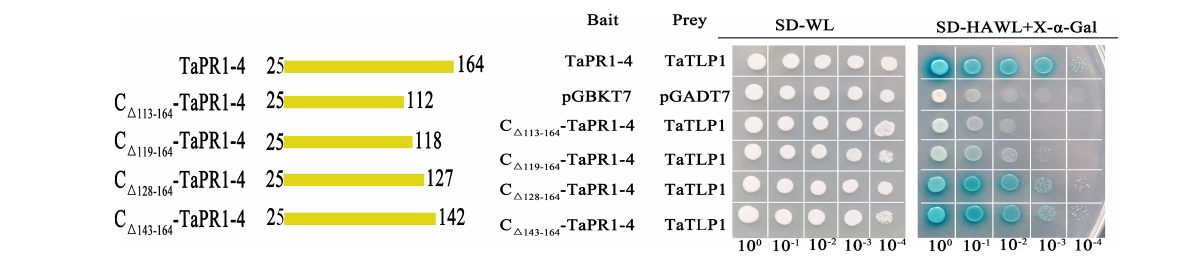
Frontiers in Plant Science |